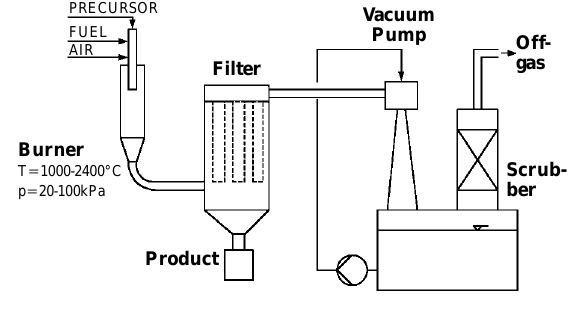
Flame reactors consist usually of the burner, a flame tube, a particle collection unit (e.g. a bag filter) and an off-gas treatment unit (e.g. an alkaline scrubber).